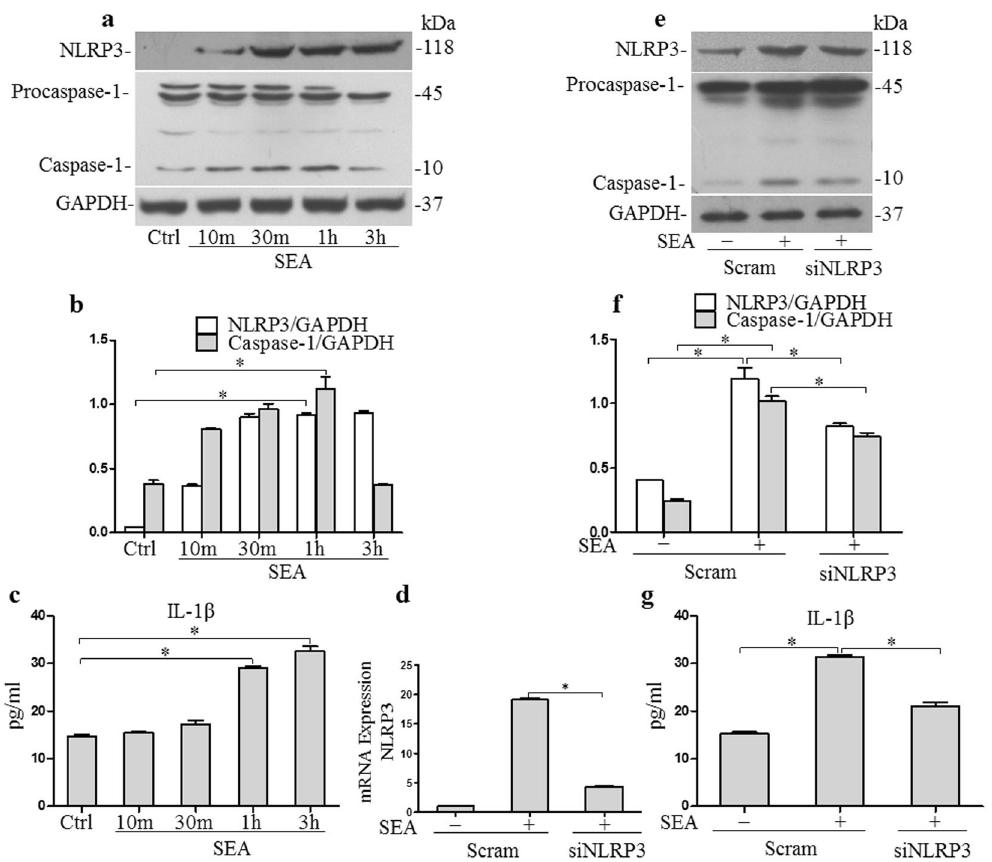
Figure 4. SEA induces NLRP3 inflammasome activation in HSCs: ( a ) Western blot gels, ( b ) summarized data showing the expression of NLRP3, pro-caspase-1 and activated caspase-1 in HSCs after stimulation with SEA (50 μ g/ml), full-length blots are included in the Supplementary Fig. S3, and ( c ) IL-1 β production in cell supernatant; ( d ) Summarized relative mRNA levels of NLRP3 in HSCs in the presence or absence siNLRP3, as determined by RT-PCR. HSCs were incubated with or without SEA (50 μ g/ml) for 2 h in the presence or absence siNLRP3; ( e ) Western blot gels, ( f ) summarized data showing the expression of NLRP3, pro-caspase-1, activated caspase-1 in HSCs, full-length blots are included in the Supplementary Fig. S4; ( g ) IL-1 β production in cell supernatant. Scram: scrambled siRNA; siNLRP3: NLRP3 siRNA. Results are a representative of at least three independent experiments. * p <